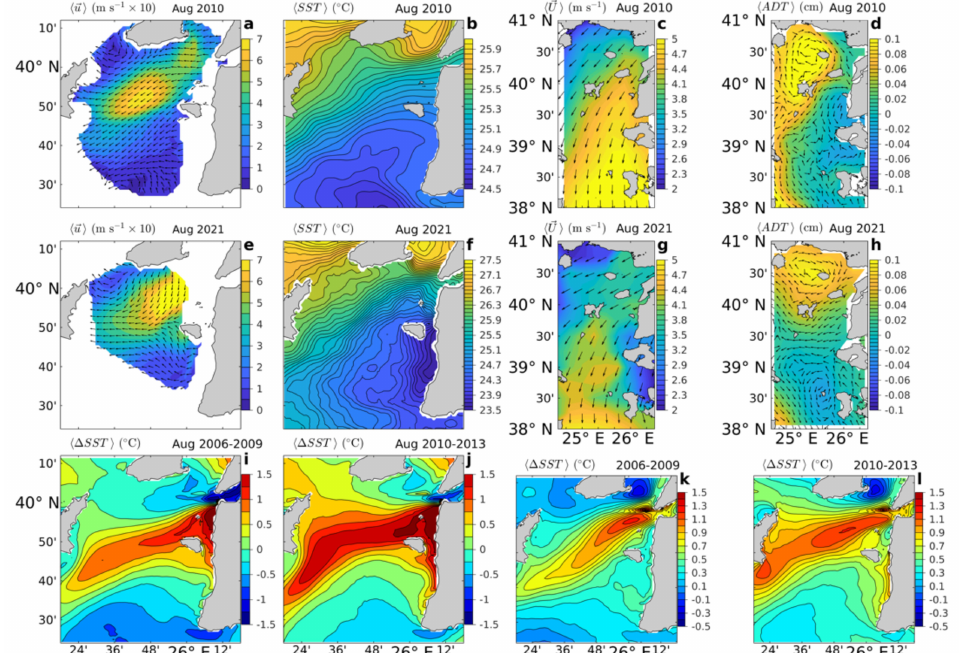
Figure 5. The first row shows the time-averaged surface velocity ( a ), sea surface temperature ( b ), wind ( c ) and geostrophic circulation ( d ) of August 2010. The geostrophic circulation is presented as the overlay of the absolute dynamic topography and the direction of geostrophic velocity. The second row ( e – h ) is the same as the first row, but for August 2021. The third row shows the difference of sea surface temperature between the model and the satellite observations for different